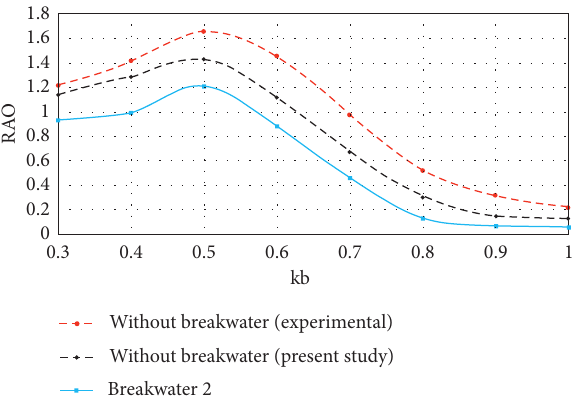
Figure 14: RAO curve for a heaving pontoon, with and without breakwater number 2.